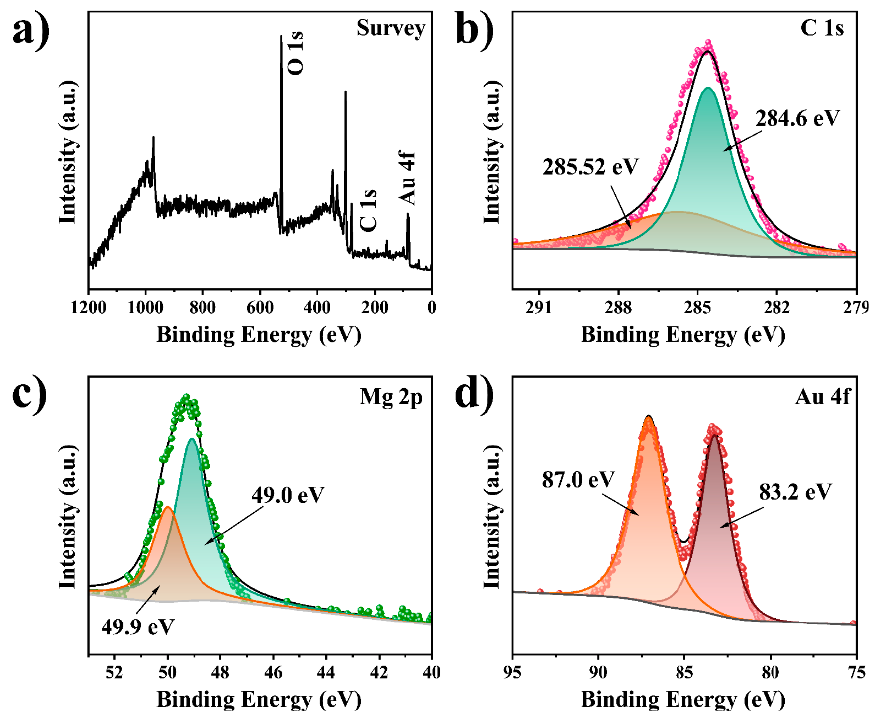
Figure 4. ( a ) XPS survey spectra, and high resolution ( b ) C 1s, ( c ) Mg 2p, and ( d ) Au 4f spectra of